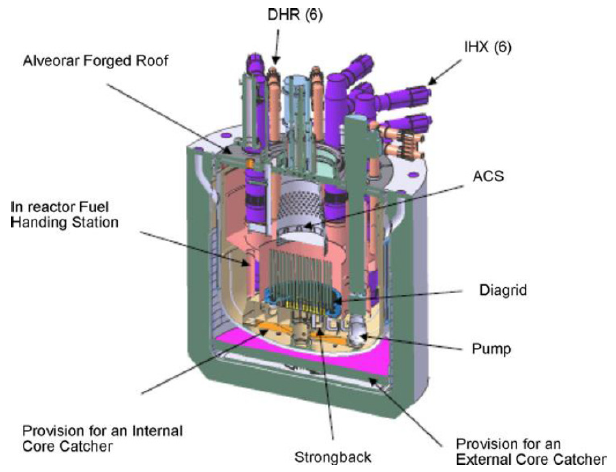
Fig. 1. ESFR pool-primary vessel scheme [1].